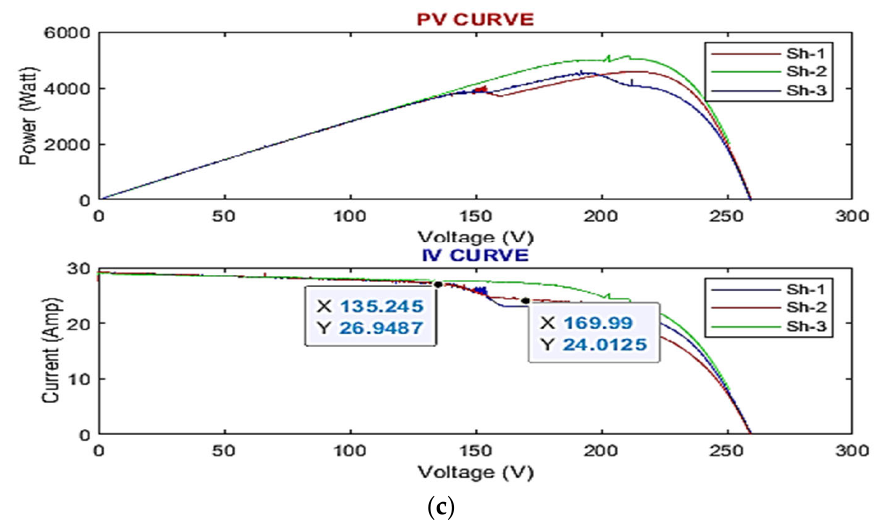
Figure 5. Impact of fault on SP configuration. ( a ) Open-circuit fault. ( b ) Short-circuit fault. ( c ) Shadowing fault